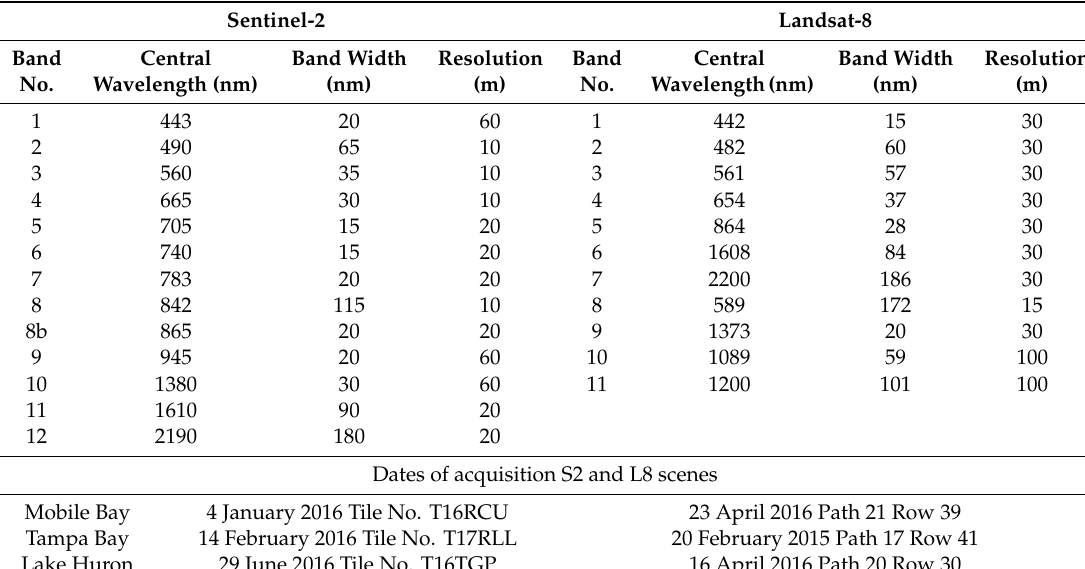
Figure 1. Location map of study area showing (black square boxes) Mobile Bay, Mississippi, the area adjoining Tampa Bay, and Lake Huron. Table 1. Key summary of Landsat-8 Operational Land Imager and Sentinel-2 Multi-Spectral Imager spectral bands, and dates of acquisition, as well as path / row and tile details of images used in this